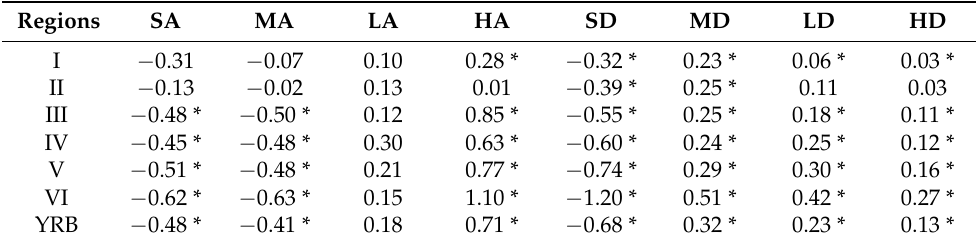
Figure 4. The contribution rate trends of different grades of precipitation events to the total precipita- tion amount and frequency ( a – h ) for the whole YRB and subregions from 1960 to 2017. Bold solid lines represent linear temporal trends. Table 3. Regional contribution rate trends for different grades of precipitation events to the total precipitation amounts and frequencies in the